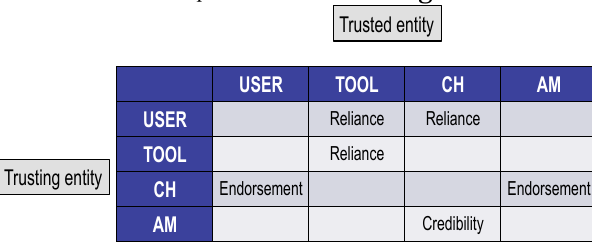
Figure 2 Trust relationships in GENI: who trusts